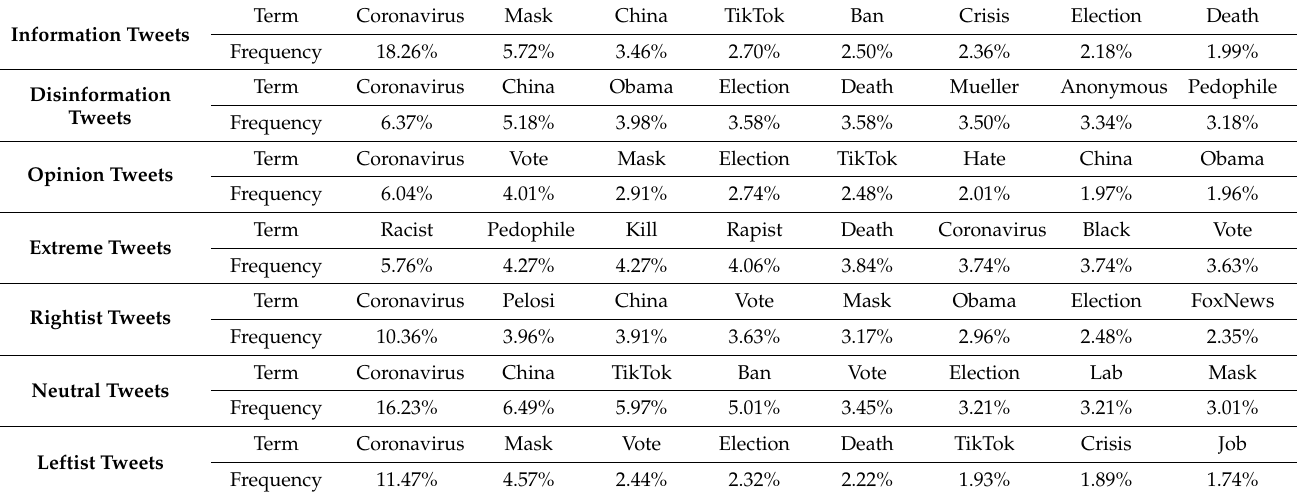
Table 4. The most frequent terms and phrases among information, disinformation, opinion, extreme opinion, rightist, neutral, and leftist